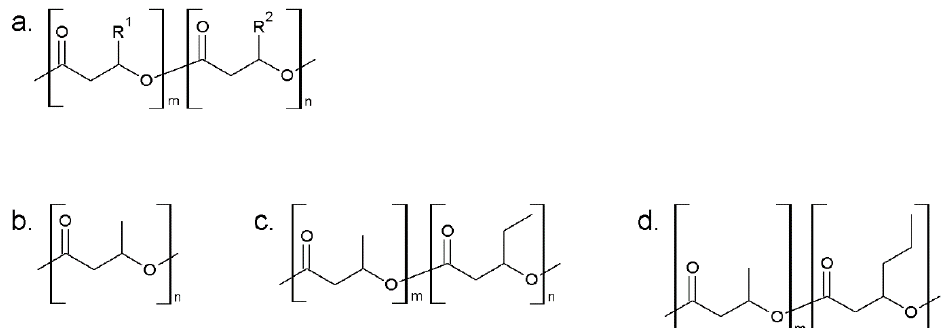
Figure 3. Overview of several poly(hydroxyl alkanoate)s (PHA) used for food packaging applications: ( a ) general structure of PHAs with residues R1/R2 as alkyl chains ranging from 1-13 carbons,